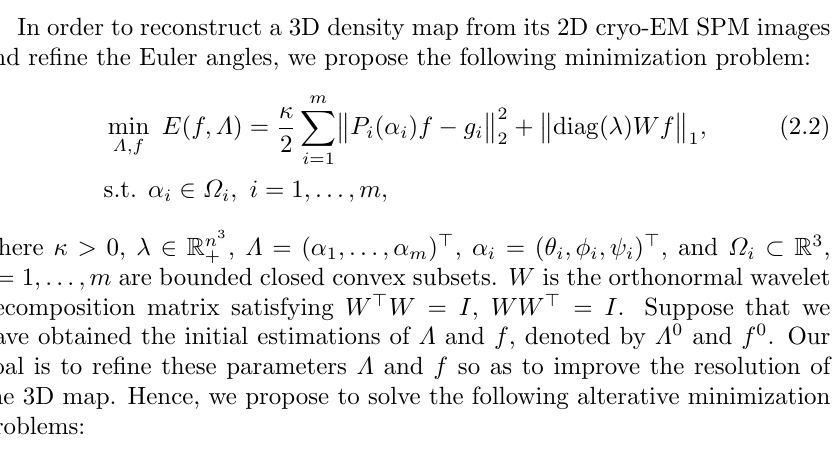
Figure 1. (a) Discretized 2D X-ray tranform; (b) Discretized 2D back